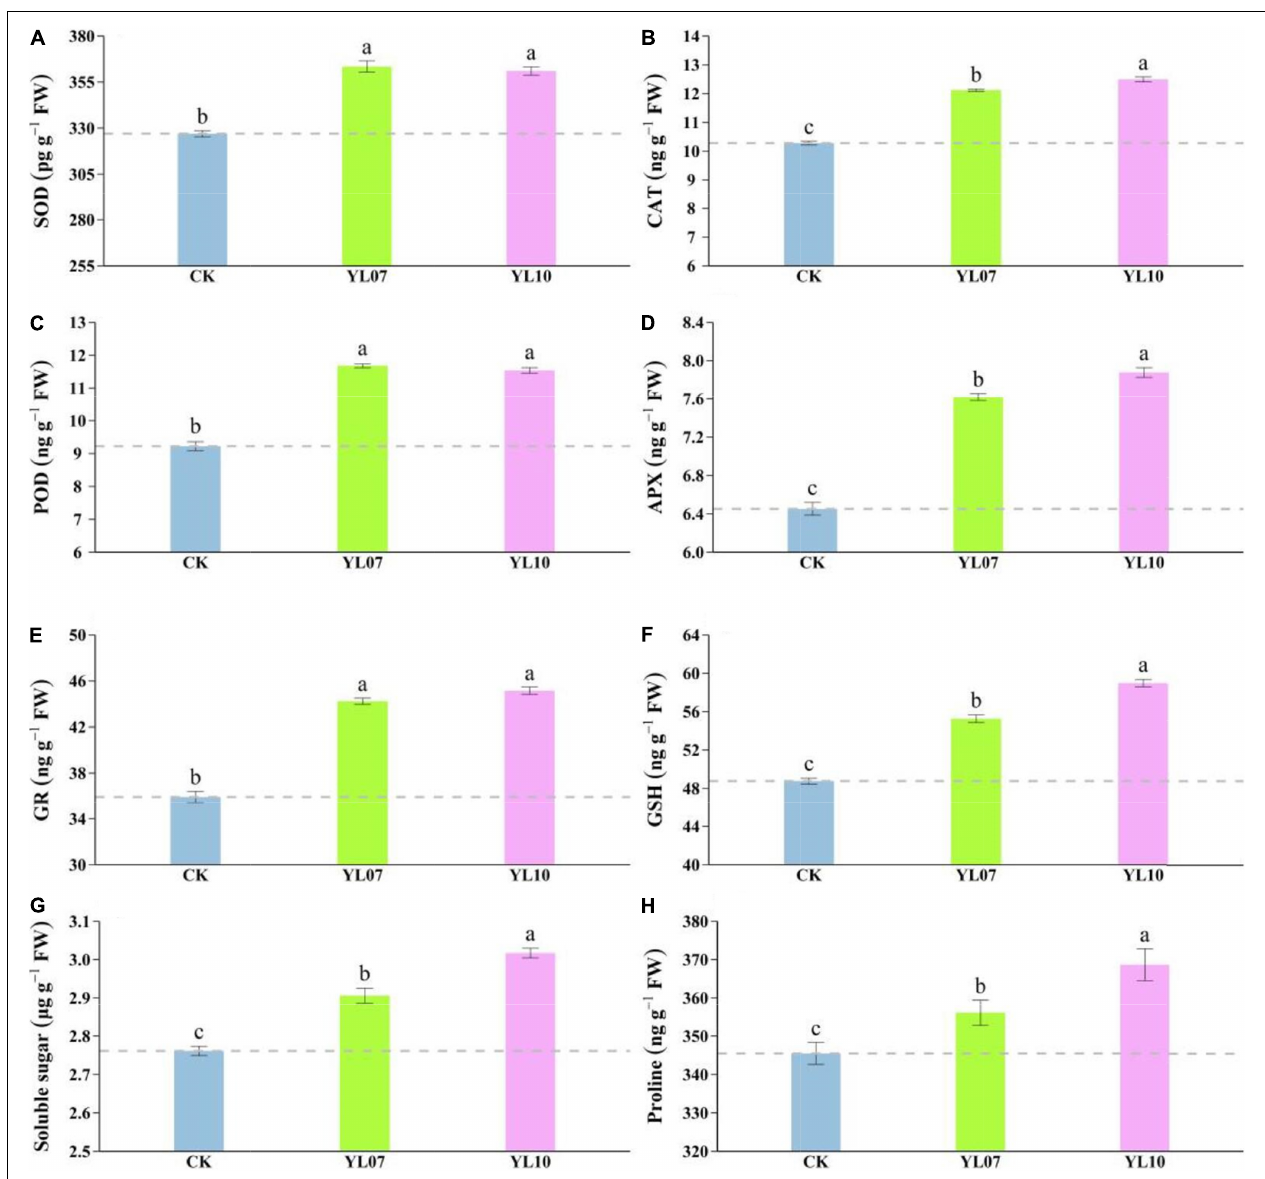
FIGURE 2 | Effect of strains YL07 and YL10 on antioxidant enzymes, including SOD (A) , CAT (B) , POD (C) , APX (D) , and GR (E) activities of maize under NaCl stress. Effects of YL07 and YL10 inoculation on GSH (F) , soluble sugar (G) , and proline (H) contents of maize grown in pots for 31 days under NaCl stress. Different letters indicate significant differences at the P < 0.05 level among the different treatments, as determined by LSD post hoc comparison tests. The content of IAA and ABA in